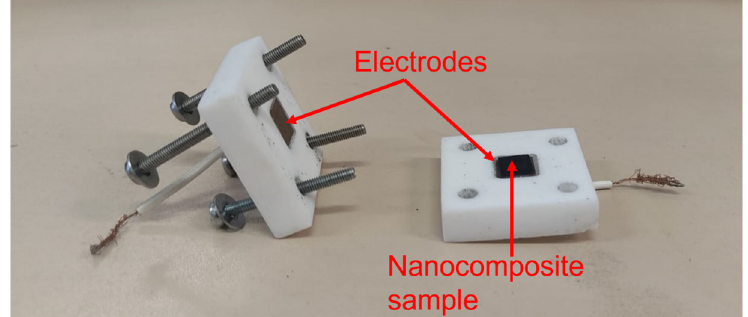
Figure 1. Set-up for electrical measurements: specimen (1 cm × 10 cm × 0.15 mm) placed in the custom-made Teflon cell and contacted by means of flat copper electrodes on the top and bottom surface.